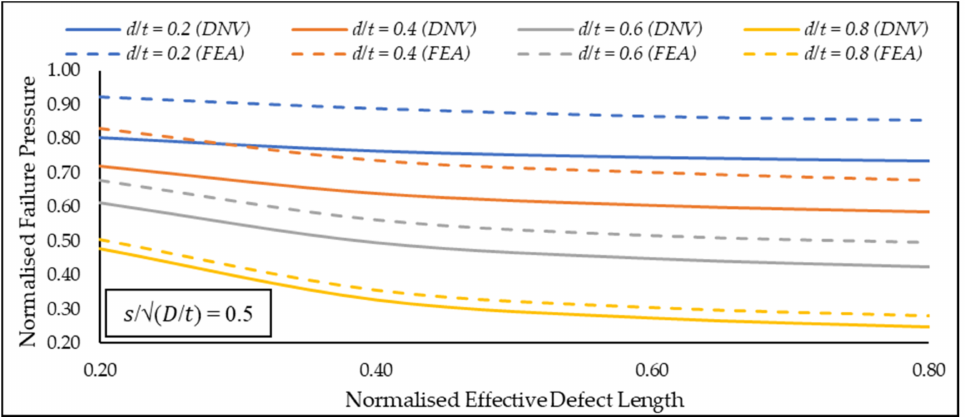
Figure 11. Normalized failure pressure predictions of FEA and DNV for API 5L X80 pipe subjected to internal pressure only for interacting defects with a normalized defect spacing of